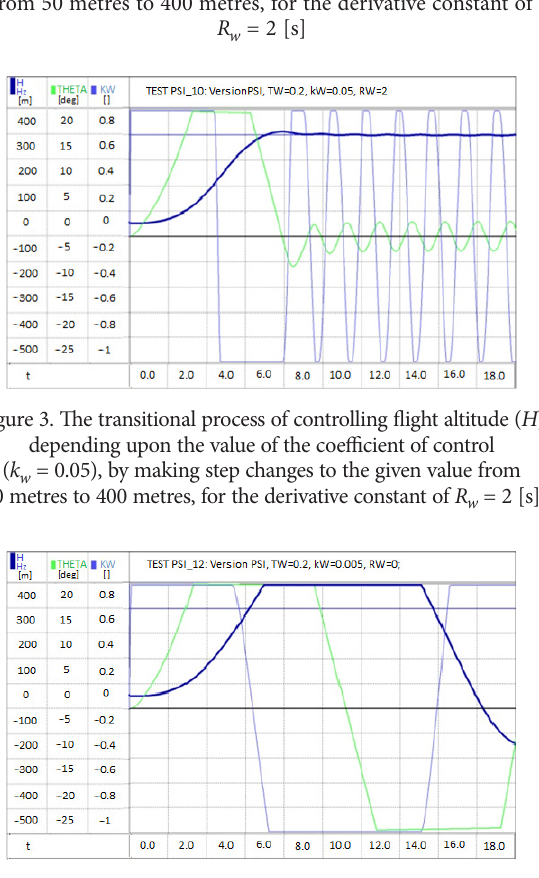
Figure 1. The transitional process of controlling flight altitude ( H ) depending upon the value of the coefficient ( k w = 0.001), by making step changes to the given value from 50 metres to 400 metres, for the derivative constant of R w = 2 [s]